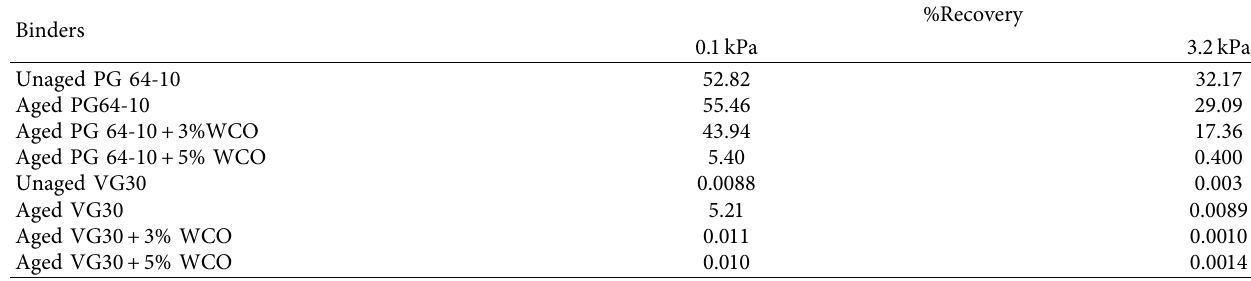
Table 3: %Recovery of the binders.